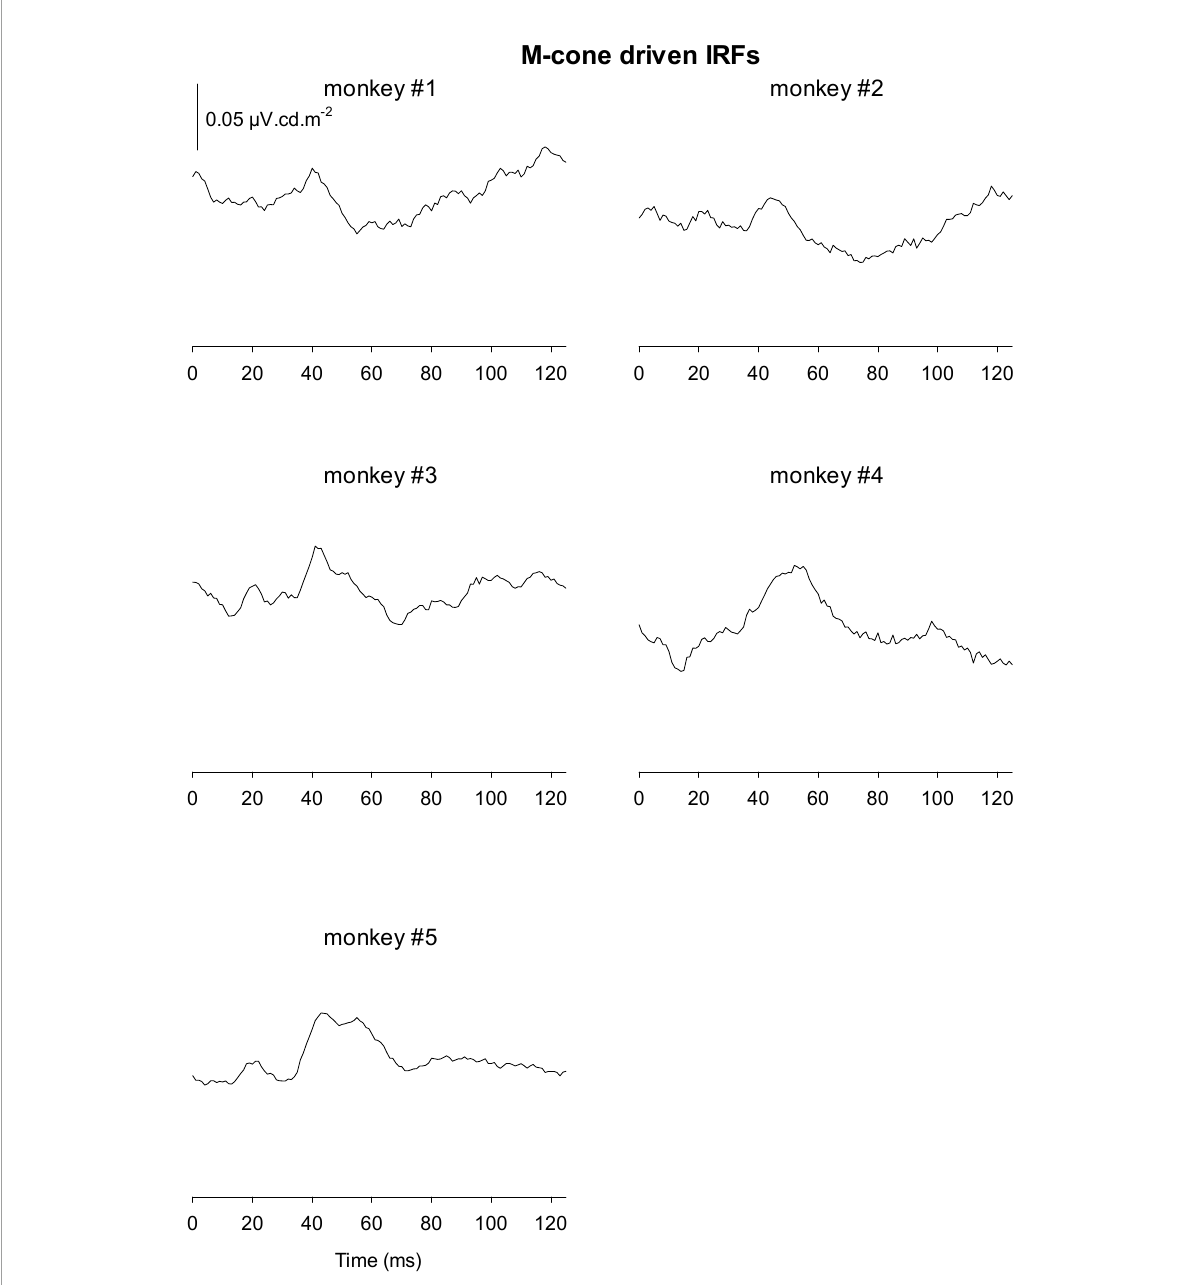
FIGURE10 IRFs derived from M-cone driven wnERGs for five